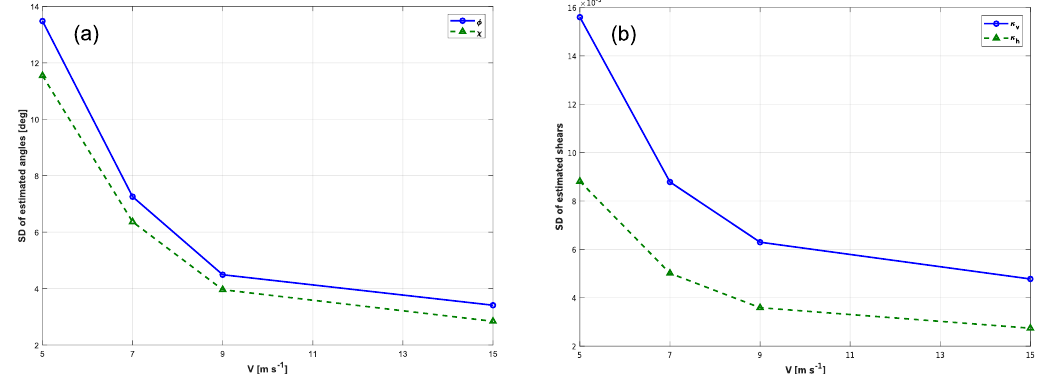
Figure 8. Expected standard deviation of the wind state estimates as a function of wind speed. (a ) Standard deviations for angles φ and χ ; (b) standard deviations for shears κ v and κ h .